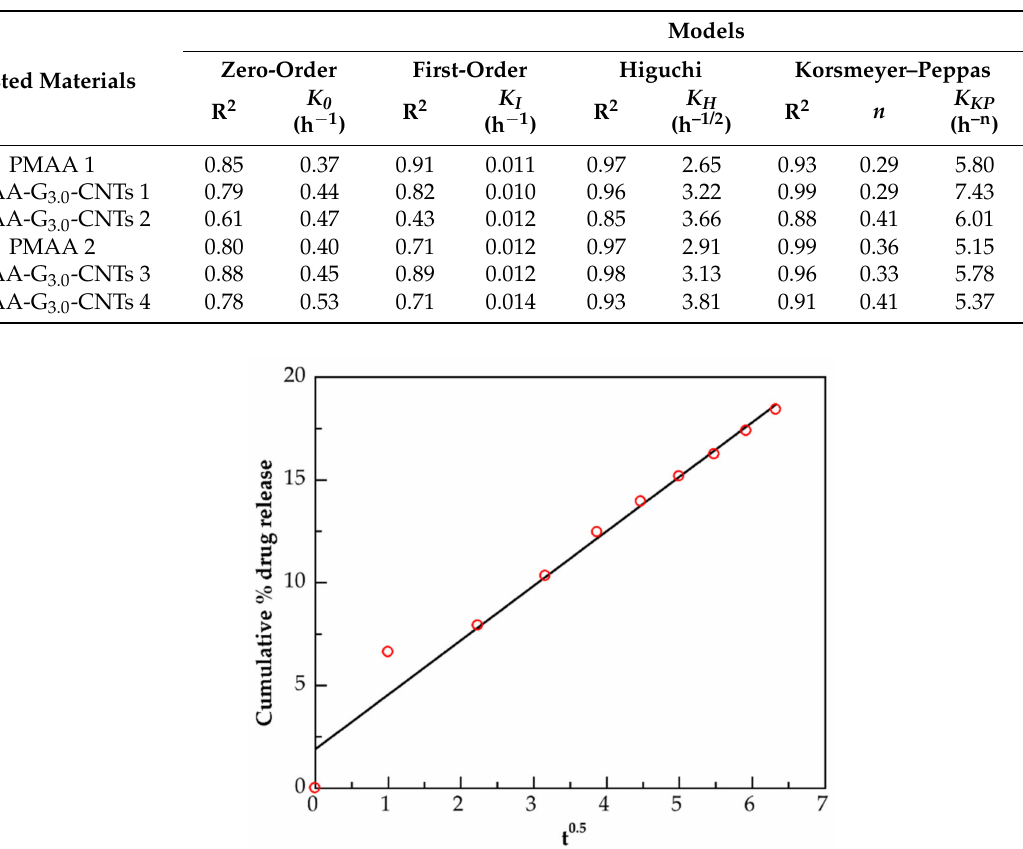
Table 4. Kinetic parameters for hydrocortisone release from tablets of PMAA 1, PMAA 2, and of their nanocomposites obtained with zero-order, first-order, Higuchi, Korsmeyer–Peppas, and Hixson–Crowell models.